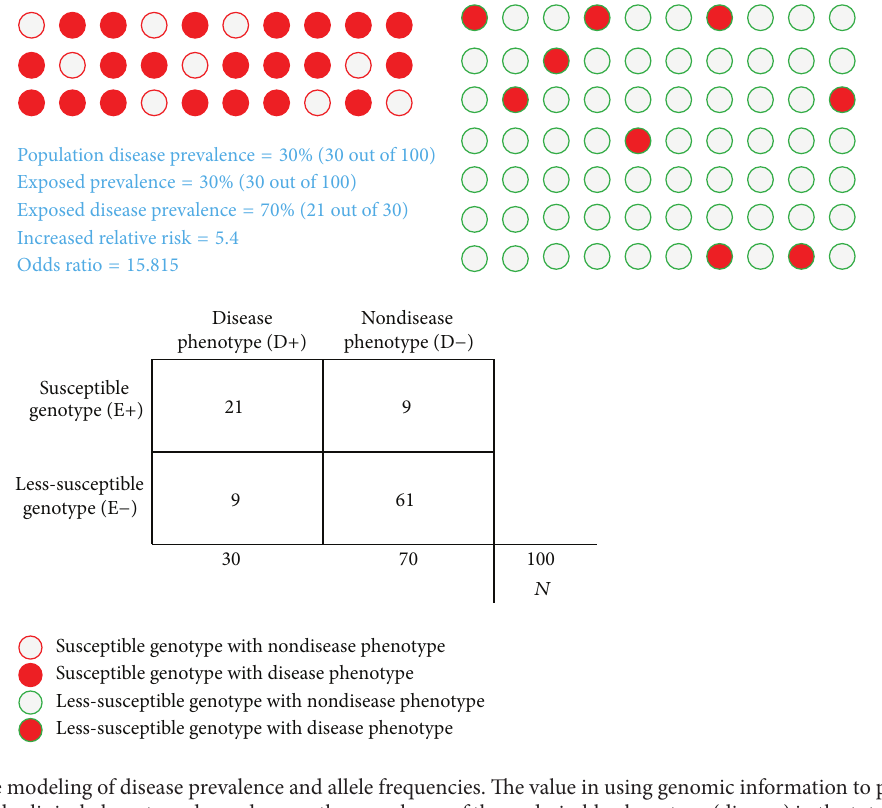
Figure 4: Predictive modeling of disease prevalence and allele frequencies. The value in using genomic information to predict individuals at risk for an undesirable clinical phenotype depends upon the prevalence of the undesirable phenotype (disease) in the total captive population, the prevalence of the susceptibility genotype (exposed), and the prevalence of the disease in the individuals with the susceptibility genotypes (disease in exposed group). The 2 × 2 matrix in the figure provides example values for a hypothetical endangered captive population of 100 individuals for which a disease phenotype has a population prevalence of 30%. The abbreviations “E+” and “E − ” correspond to exposed and nonexposed, respectively. In this model, the exposed group has the allele/genotype(s) associated with the undesirable phenotype, while the nonexposed group does not have the susceptibility allele. Genotype-phenotype predictions, based on drastic SNP occurrence in genes associated with comparative genomics phenotype annotations derived from knockout mouse models, allow classification of members of the endangered species population into either a susceptible or less-susceptible class. Through bidirectional communication among zoo veterinarians, SSPs, zoo staff, and genomics scientists, genotype-phenotype predictions may be validated. Threshold values for increased relative risk in the exposed group, along with threshold levels of allele/genotype frequencies in the E+ and E − groups, will affect the success in employing such an approach for captive species management, as will the mode of inheritance (e.g., autosomal recessive versus autosomal